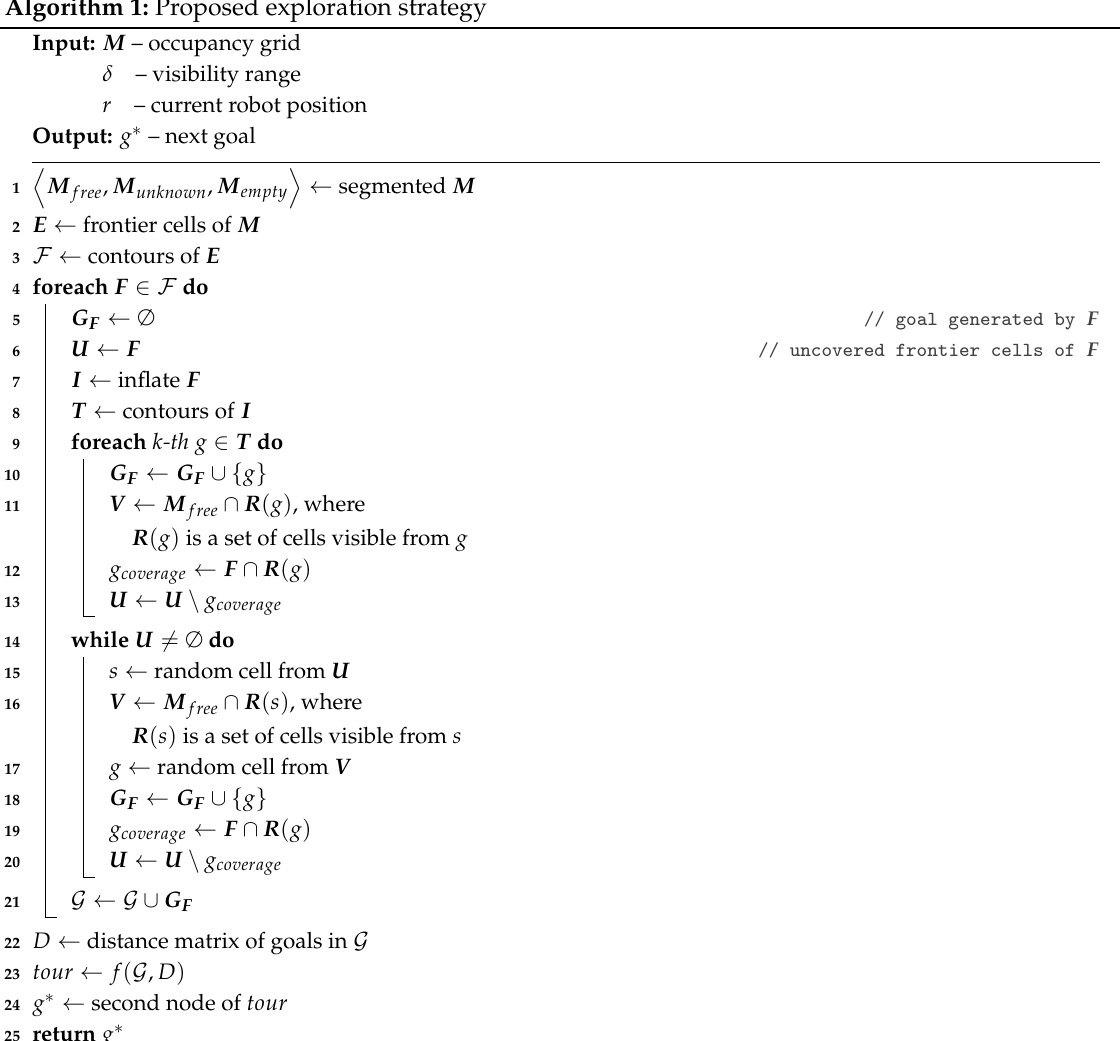
Algorithm 1: Proposed exploration